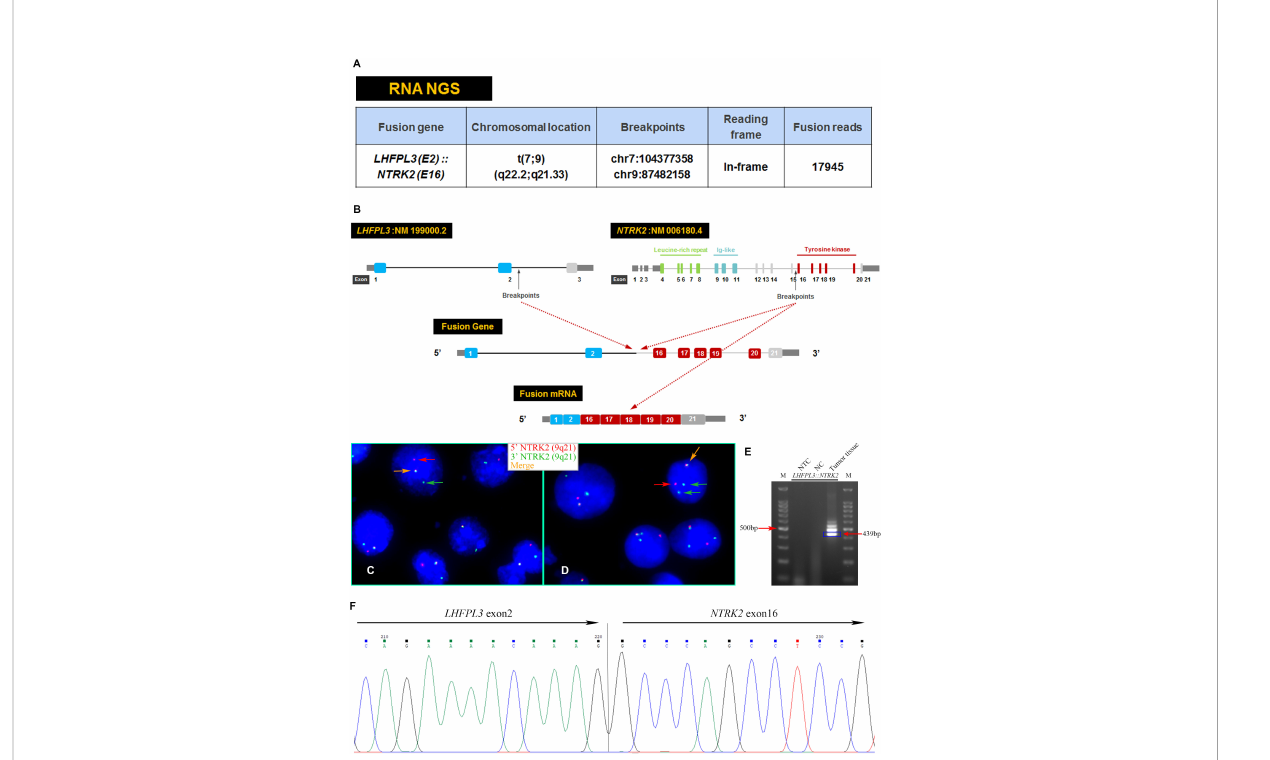
FIGURE 2 Characterization of the LHFPL3::NTRK2 fusion. (A) Targeted RNA NGS revealed an LHFPL3::NTRK2 fusion transcript with an intact reading frame. (B) A schematic diagram showed the breakpoints of LHFPL3 and NTRK2 , with the fused gene retaining the tyrosine kinase domain of the NTRK2 . (C, D) FISH with an NTRK2 split-apart probe showed the separation of the 5 ’ NTRK2 (Red) from the 3 ’ NTRK2 (Green), consistent with the NTRK2 gene rearrangement. (E) RT-PCR con fi rmed the expression of LHFPL3::NTRK2 fusion transcript. (F) Sanger sequencing of the PCR product con fi rmed the breakpoints of LHFPL3 and NTRK2 genes. NTC, No Template Control; NC, Negative